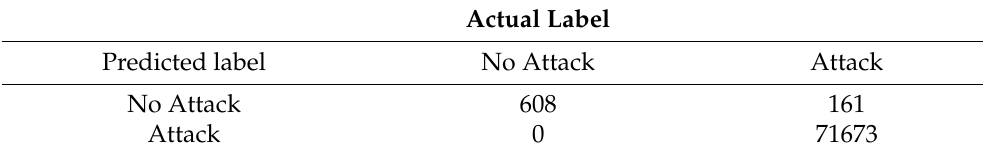
Table 26. OS Scan RF confusion matrix.